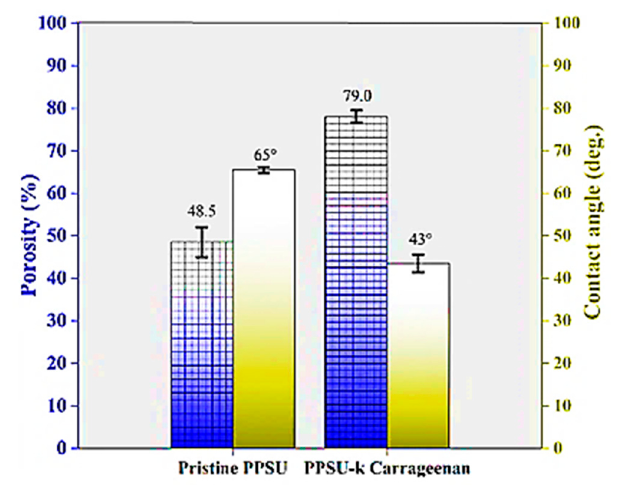
Figure 18. Porosity (%) of Polysulfone–ulvan membranes with different solvents [86]. Another sulfated seaweed polysaccharide, κ -carrageenan (KCA), was tested as a pore former to develop highly porous polyphenylsulfone (PPSU) membranes. Morphology reveals that the finger-like structure changed to a porous (porosity 48 ± 3% to 78 ± 2%) structure with uniform pores (~2 nm to 1.1 μ m) [87]. Similarly, KCA (0.5, 1.0, 2.0 wt.%) was used as a hydrophilic additive to fabricate polyvinylidene fluoride (PVDF) composite membranes. The addition of KCA induced demixing speed and enhanced the hydrophilic nature (Figure 19), which prevented the dye adhesion on the composite membrane PVDF/KCA surface.